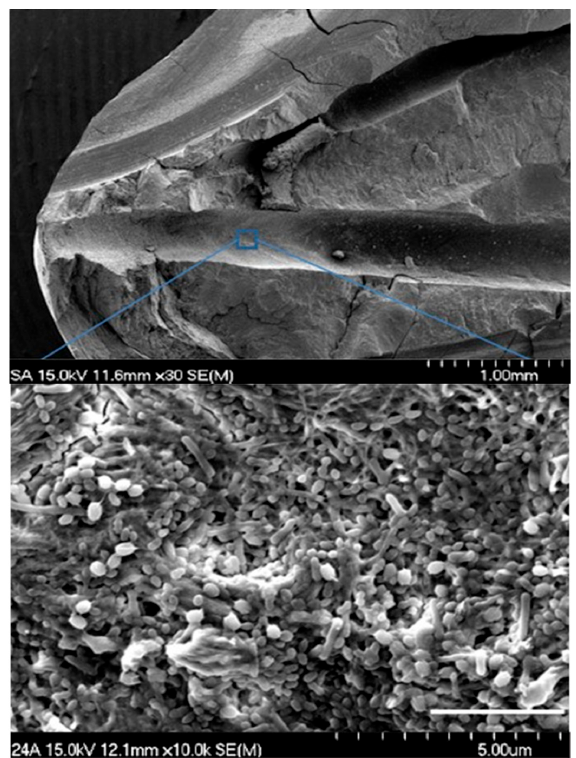
Figure 2. Representative SEM images of the apical-third region from the molars inoculated with E. faecalis (Upper, 30× magnification), randomly selected with apical-third region (Lower, 10,000× magnification) in positive Control group.